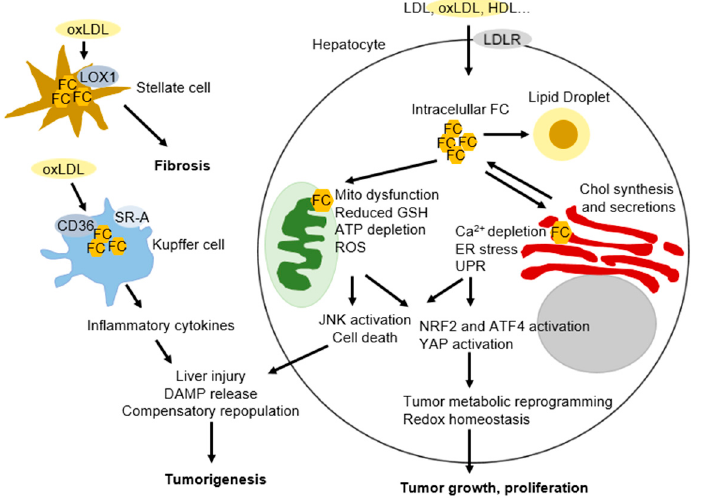
Figure 2. FC induces HCC formation and development. In hepatocytes, cholesterol, mainly in the forms of LDL, oxLDL, HDL, and chylomicron remnant, is internalized via LDLR-mediated endocytosis and cholesterol esters are then hydrolyzed by acid lipase enzymes in the endosomes and/or lysosomes, ultimately leading to the elevated intracellular FC pools. FC is transported to various organelles, such as mitochondria (Mito), endoplasmic reticulum (ER), and lipid droplets, via different protein carriers. Overload of FC into ER causes ER calcium depletion, ER stress, and sequential adaptive response-unfolded protein response (UPR). Accumulation of FC into Mito leads to Mito dysfunction including reduced GSH levels in the Mito, ATP depletion, and generation of ROS. If the stress in the ER and Mito induced by FC are too severe or prolonged, ER and Mito stress trigger cell death and subsequent release of damage-associated molecular pattern (DAMP) including HMGB1 and oxidized Mito-DNA, resulting in liver injury and compensatory proliferation. In addition, cholesterol uptake in the hepatic stellate cells by lectin-like oxidized LDL receptor-1(LOX-1) triggers stellate cell activation and fibrosis. Internalization of cholesterol into Kupffer cells by CD36 or scavenger receptor A (SR-A) leads to Kupffer cells activation and release of proinflammatory cytokines, which also contributes to liver injury, inflammation and HCC initiation. Furthermore, FC-mediated ER and Mito stress activates NRF2 and ATF4, two key transcription factors in the stress response to mediate the survival of stressed hepatocytes. oxLDL uptake into cancer cells promotes lipophagy and enhances YAP oncogenic activity. If the stress is reparable, activated NRF2, ATF4, and YAP maintain the cancer cell redox homeostasis and reprogram metabolism for the HCC growth and proliferation.